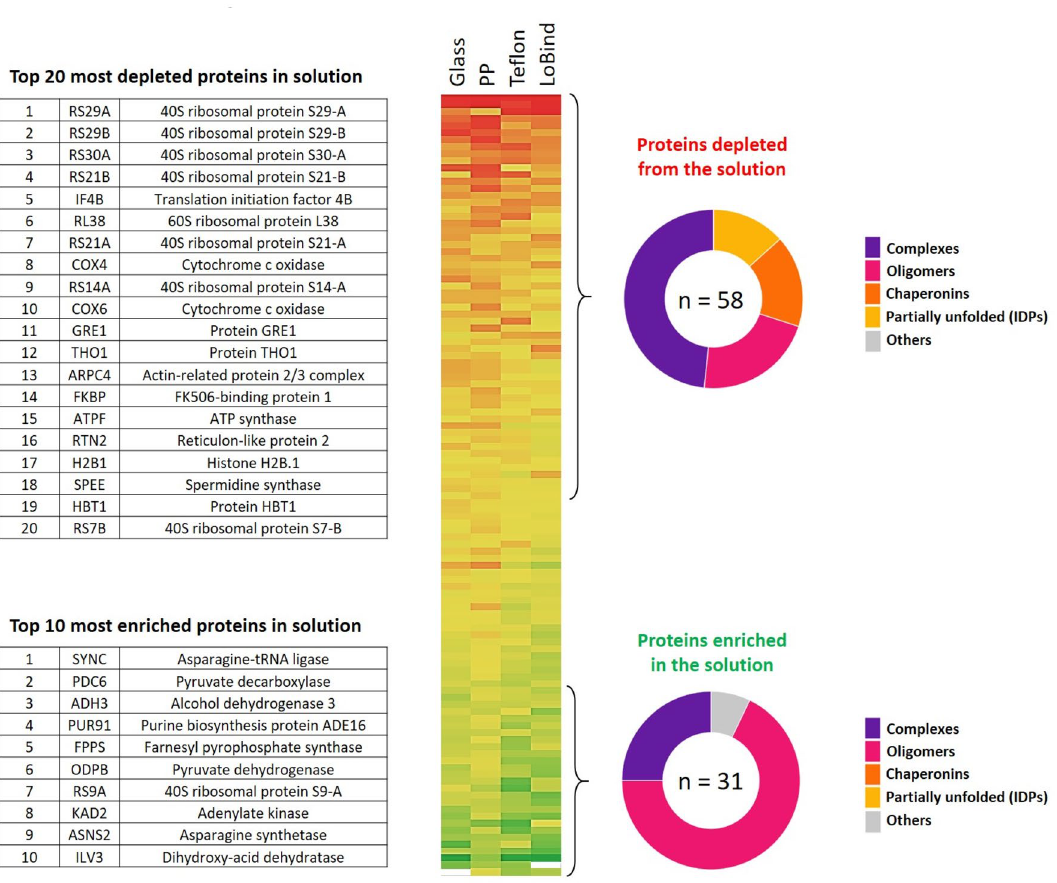
Figure 11. Quantitative proteomic analysis of protein depleted from and enriched in the solution after mixing YPE in PP, TEFLON, glass, LOBIND tubes at 3 rpm for 24 h at 6 °C. The color gradient indicates the status of the proteins: depleted (red) to enriched (green). The protein characteristics are issued from the Uniprot database 41 . A list of all considered proteins is given in supporting file